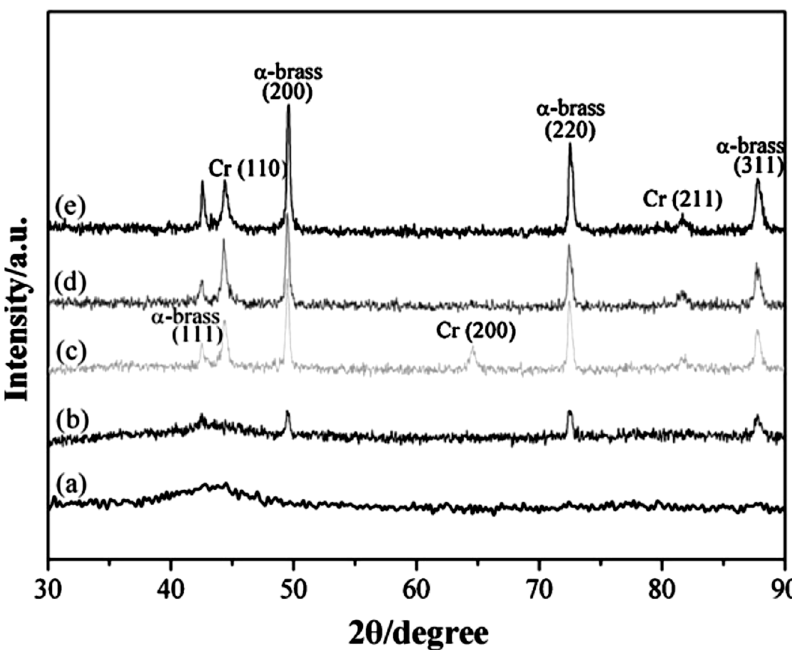
Figure 6. XRD patterns of the deposits from the trivalent Cr bath ( a ) without thiosalicylic acid and containing ( b ) 0.00083, ( c ) 0.0025, ( d ) 0.005, and ( e ) 0.0083 mthiosalicylic acid. Reprinted with permission from [65]. Copyright 2012 Elsevier